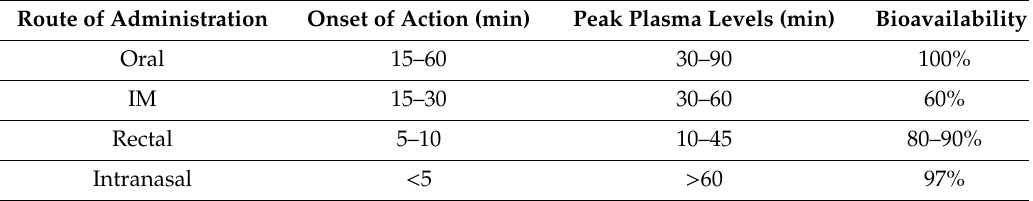
Table 2. Pharmacokinetic parameters of diazepam following various routes of administration [31–33].